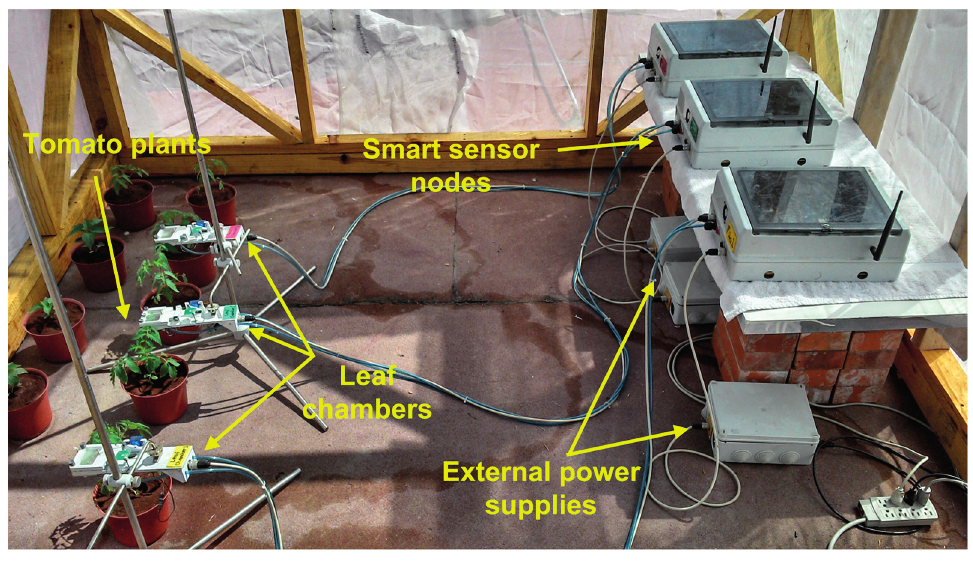
Figure 4. Experimental setup for smart sensors under real operating